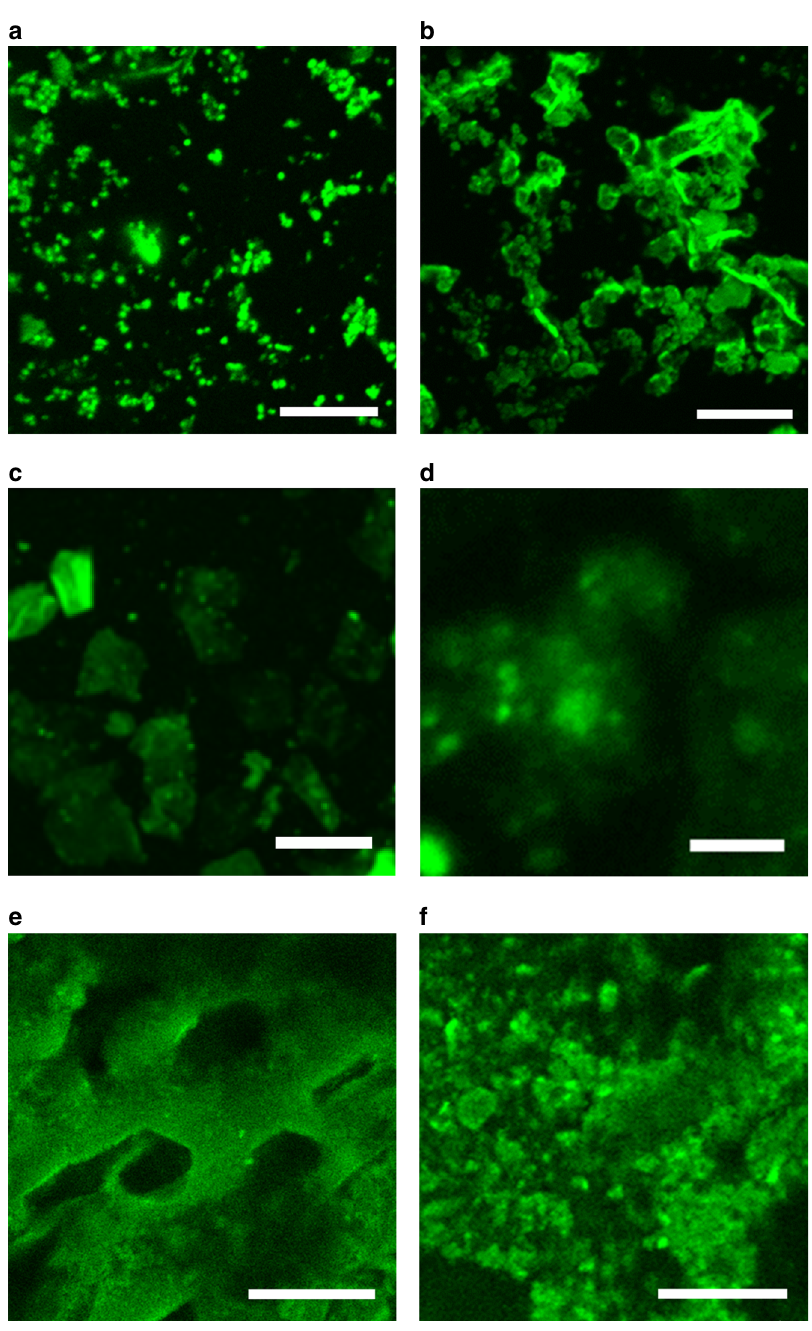
Fig. 4 Confocal images of β -sheets-incorporated networks stained via ThT assay. a , b Hydrogels with different content of β -sheets from HB60 and HB360, respectively (scale bars are 5 μ m); c Hydrogel with disrupted β -sheets within GH10 (scale bar is 50 μ m); d Magni fi ed β -sheets from GH10 (scale bar is 5 μ m); e Cryogel with β -sheet from CB360 (scale bar is 50 μ m); f Magni fi ed β -sheets from CB360 (scale bar is 10 μ